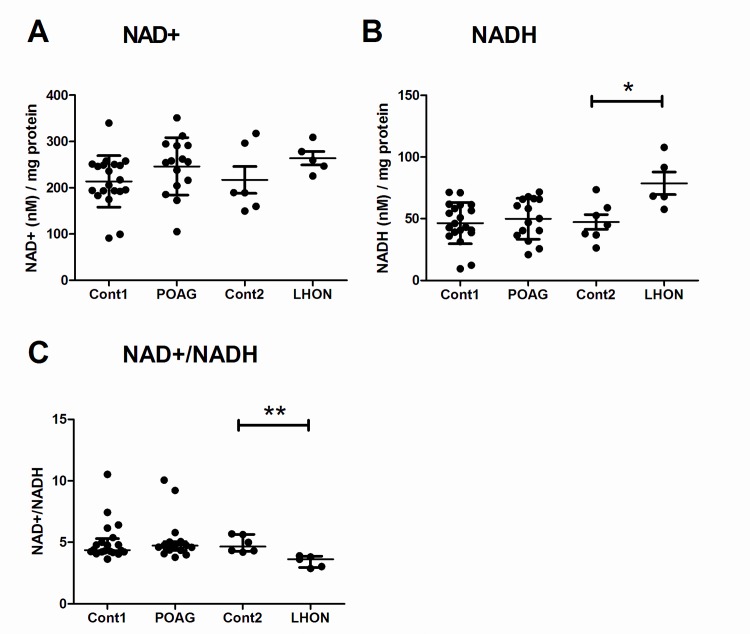
Decreased NAD+/NADH redox balance in LHON lymphoblasts.Lymphoblasts were grown in regular RPMI media for 48 hours prior to lymphoblasts being harvested to measure NAD+ and NADH levels. There was no significant difference in A) NAD+ levels between any groups; however there was a significant increase in B) NADH levels in LHON patients leading to C) a significant decrease in the NAD+/NADH ratio in LHON lymphoblasts. There was no difference between any of these measured parameters in POAG lymphoblasts, and cellular protein content was similar between groups (data not shown). For NAD+ and NADH data is mean ± SD, students t-test, and for NAD+/NADH data is median (IQR), Mann-Whitney test, n = 20 cont1, n = 15 POAG, n = 6 cont2 and n = 6 LHON, * = p< 0.05, ** = p< 0.01.